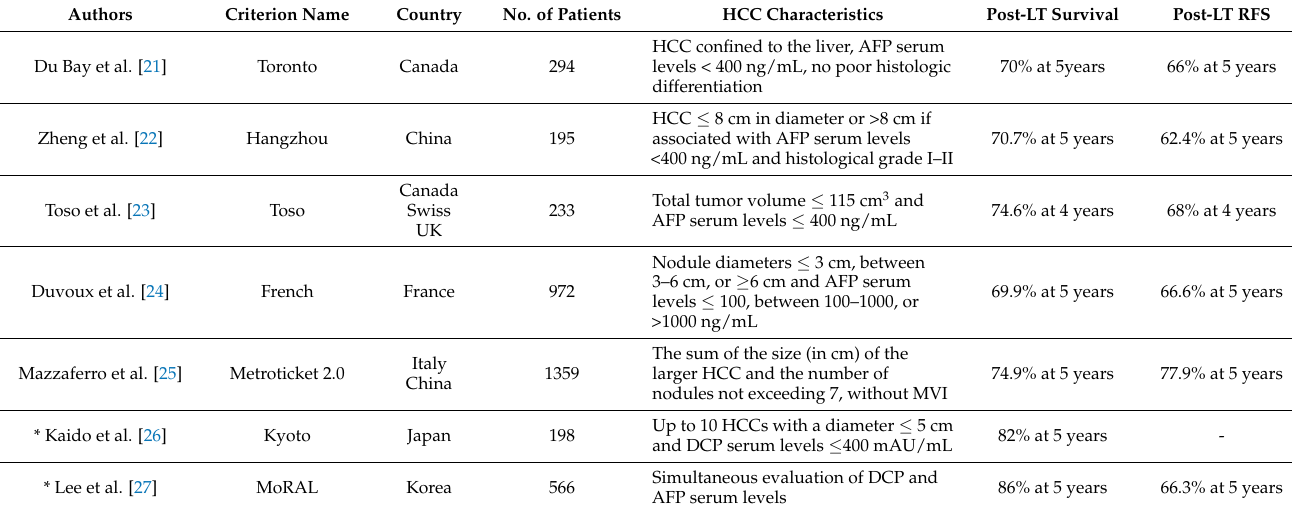
Table 2. The preoperative selection criteria for liver transplantation (LT) in patients with hepatocellular carcinoma (HCC) based on the addition of the biological serum markers and/or histological differentiation grade to the morphological characteristics of the tumor. Only the externally validated selection criteria are reported in the table.